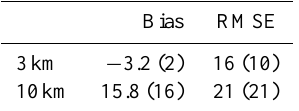
Figure 2. Sea mask used to calculated ozone averages over the Mediterranean (blue dots). The dots represent the grid cells con- sidered in the averages. Table 1. Mean relative bias and root mean square of errors (RMSE) of IASI ozone observations at 3 and 10km. They are derived from the comparison of IASI observations and ozone-sonde measure- ments at Madrid and Ankara over the summertime periods between 2007 and 2012 (see text for more details). Bias and RMSE are given in percent and in ppbv (in parenthesis).